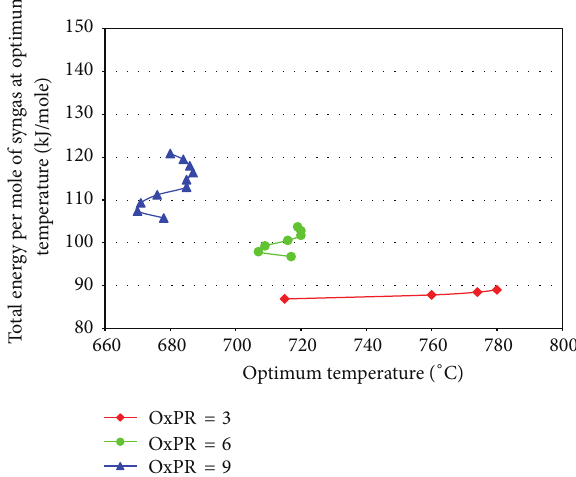
Figure 7: Syngas moles at optimum temperature in CR of propane. reforming condition, the syngas ratio increased from 2.5413 (OxPR = 3) to 5.5884 (OxPR = 9). The maximum syngas ratio was found to be 5.5884 at pure steam reforming condition of OxPR = 9, while the minimum syngas ratio was found to be 0.3919 at pure dry reforming condition of OxPR =